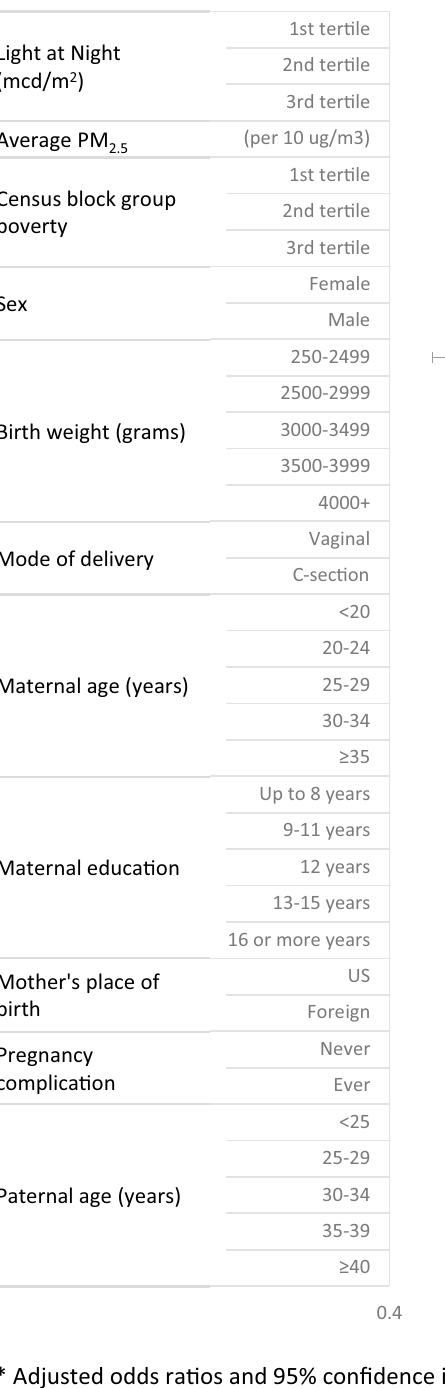
Figure 1. Association between outdoor artificial light at night, air pollution, birth characteristics, and risk of childhood acute lymphoblastic leukemia among Hispanic children in the California Linkage Study of Early- Onset Cancers. *Adjusted odds ratios and 95% confidence intervals were derived from a multivariable logistic regression model that simultaneously included all variables listed in this